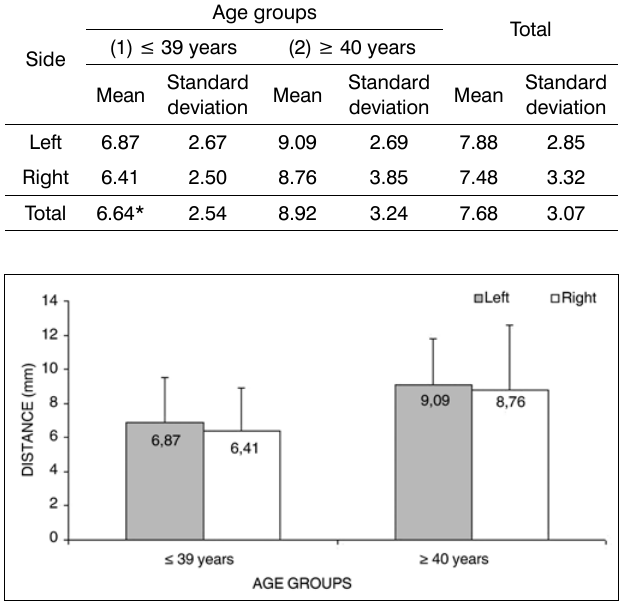
Figure 2. Measurement 1 relative to age and side, in mm (mean ± standard deviation) - measurement 1 (the shortest measurement from the EBSLN to the most cranial point of the thyroid gland lobe). Table 5. Measurement 2 relative to age group and side. in mm.